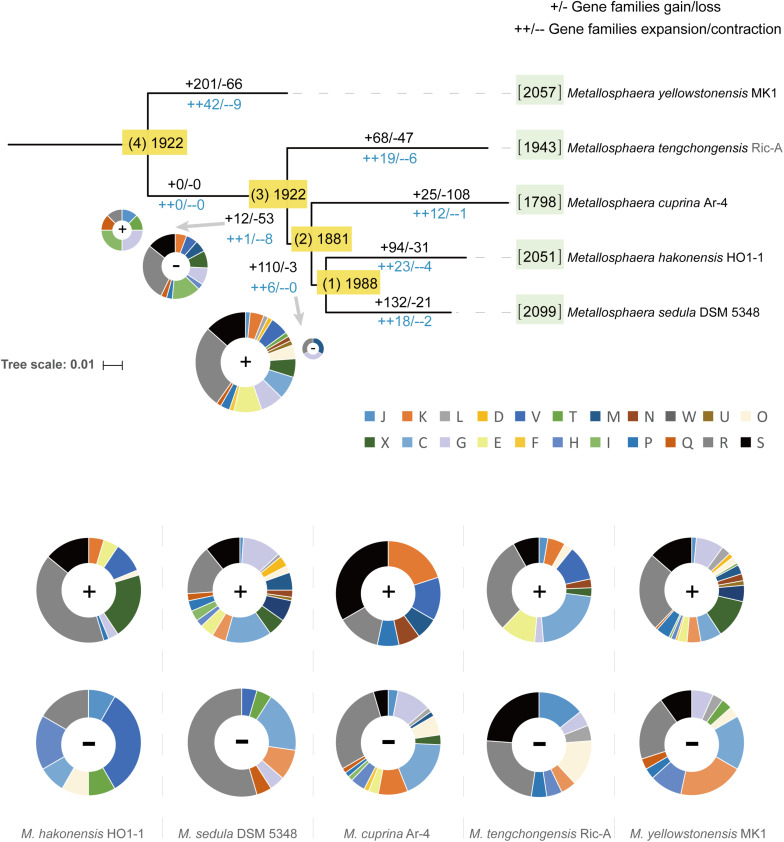
Ancestral genome content reconstruction of Metallosphaera species with COUNT software. The numbers of gene families of each strain were shown in brackets before the names of strains. The numbers of gain and loss events were marked at each lineage of the tree. “+”s represent gain events and “–”s represent loss events. The pie chart shows the numbers of gained genes by COG categories. A list of gained and lost genes for the Metallosphaera-type strains, and nodes 1 and 2 are shown in Supplementary Table S4. COG categories description (J, translation, ribosomal structure and biogenesis; K, transcription; L, replication, recombination and repair; D, cell cycle control, cell division, chromosome partitioning; V, defense mechanisms; T, signal transduction mechanisms; M, cell wall/membrane/envelope biogenesis; N, cell motility; U, intracellular trafficking, secretion, and vesicular transport; O, posttranslational modification, protein turnover, chaperones; X, mobilome: prophages, transposons; C, energy production and conversion; G, carbohydrate transport and metabolism; E, amino acid transport and metabolism; F, nucleotide transport and metabolism; H, coenzyme transport and metabolism; I, lipid transport and metabolism; P, inorganic ion transport and metabolism; Q, secondary metabolites biosynthesis, transport and catabolism; R, general function prediction only; S, function unknown).